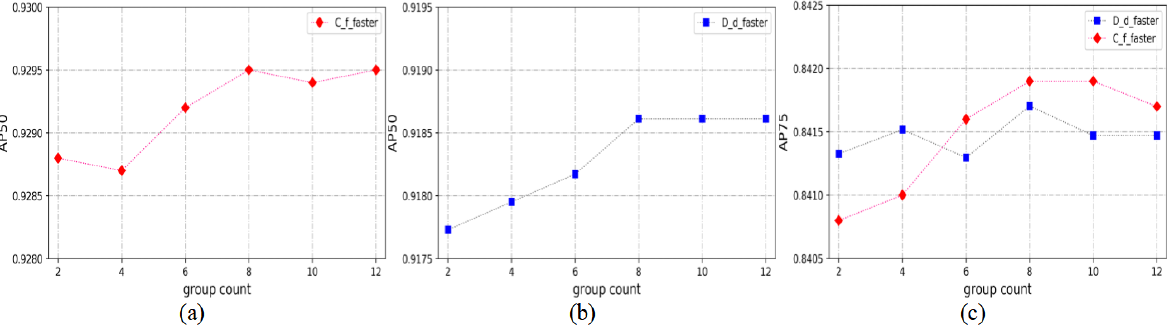
Figure 12. ( a ) is the graph of AP50 and the number of scale scaling factor groups in Correlation filter + Faster, ( b ) is the graph of AP50 and the number of scale factor groups in the Discriminant dictionary + Faster, ( c ) is the graph of AP75 and the number of scale factor groups in two